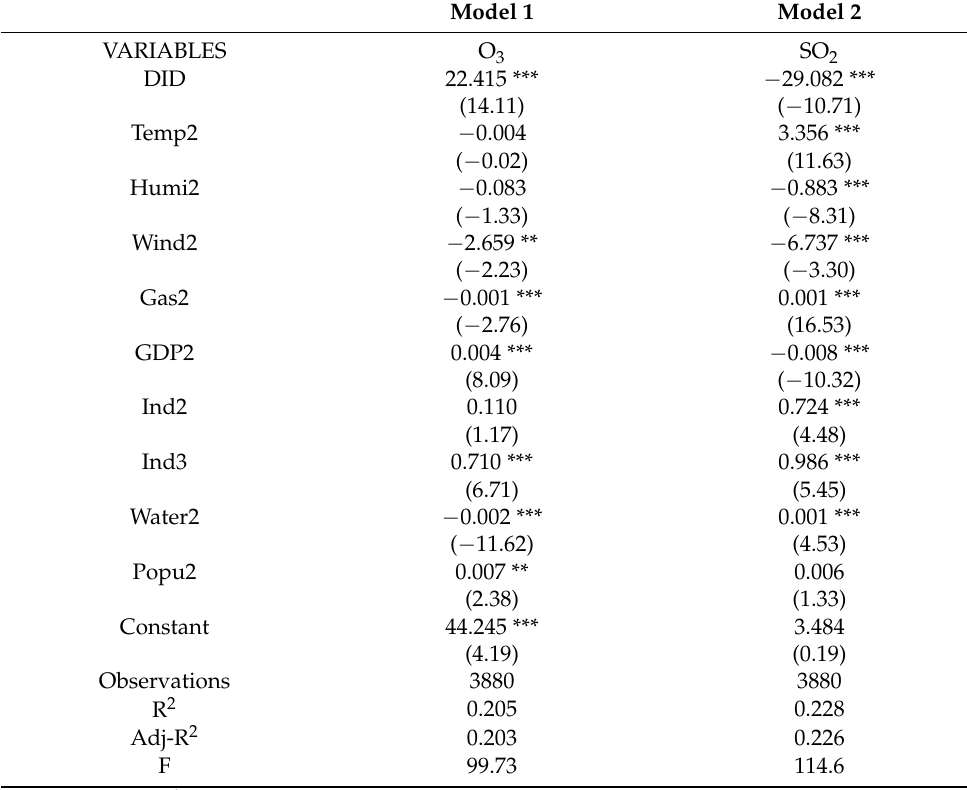
Table 9. Robustness test results.